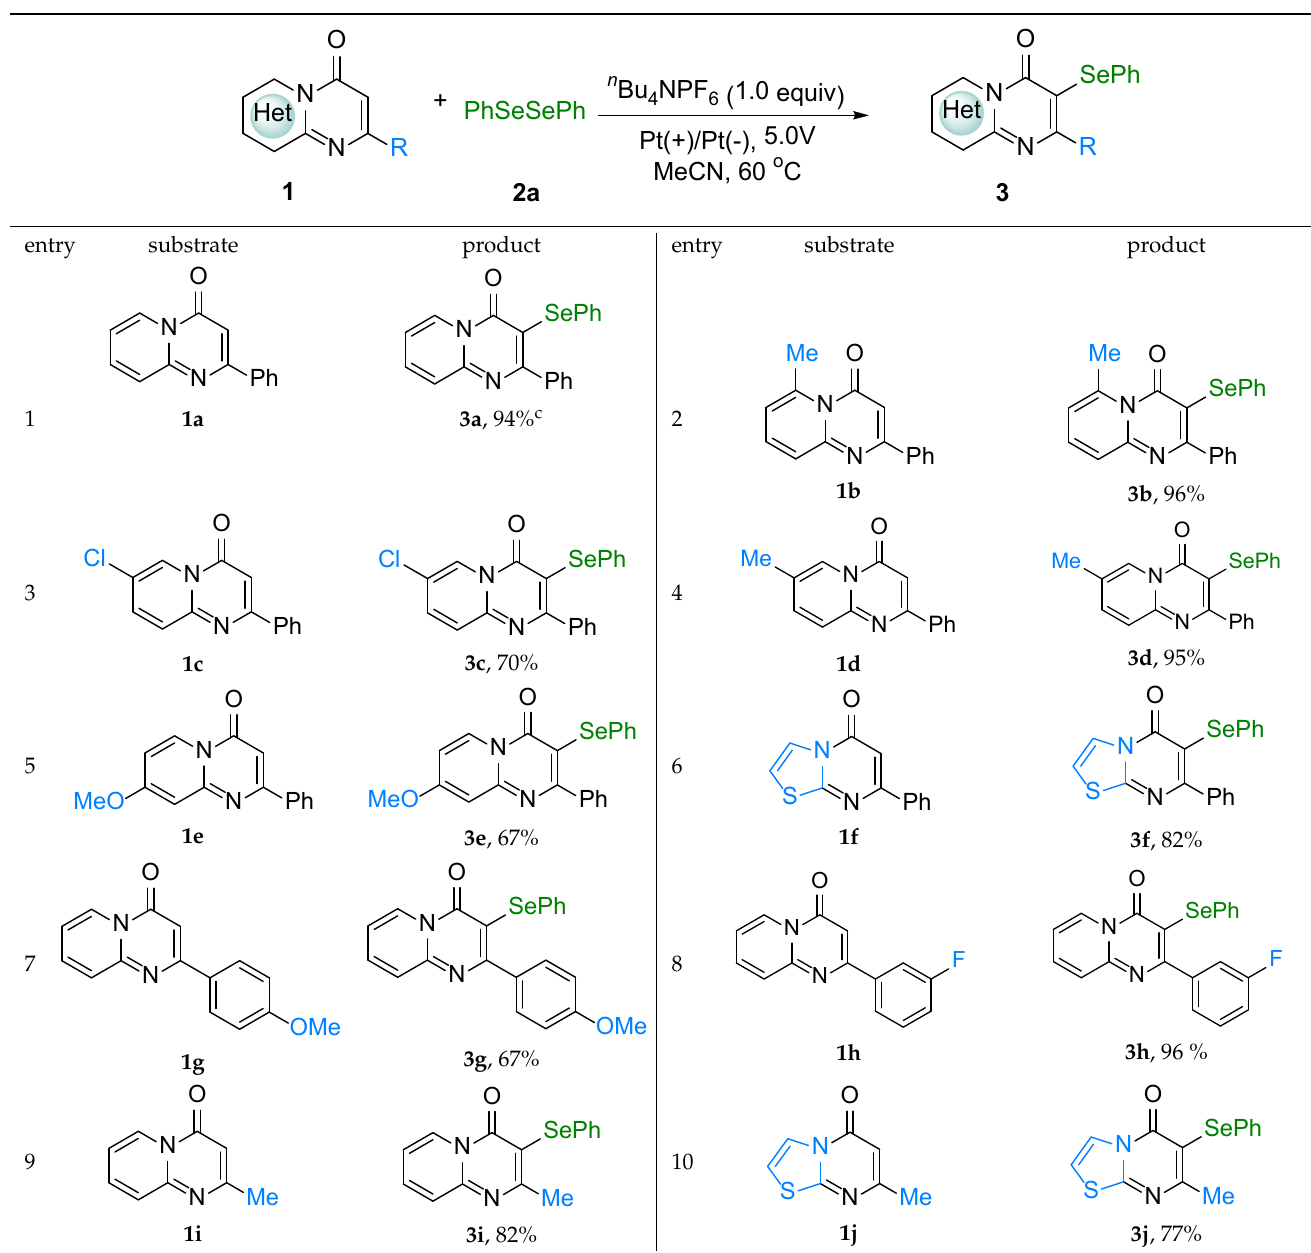
Table 2. Substrate scope of pyrido[1,2- a ]pyrimidin-4-ones a,b .